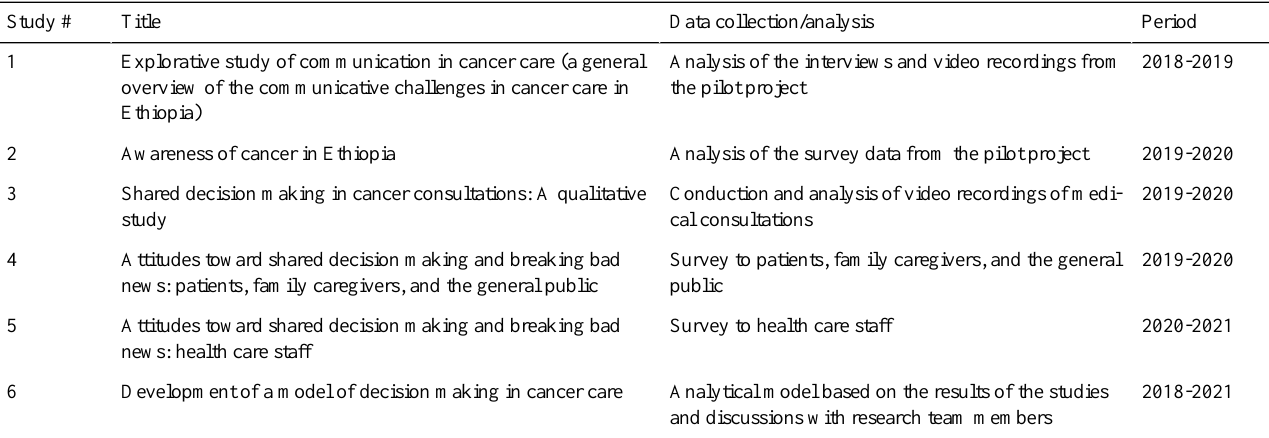
Table 1. Overview of research